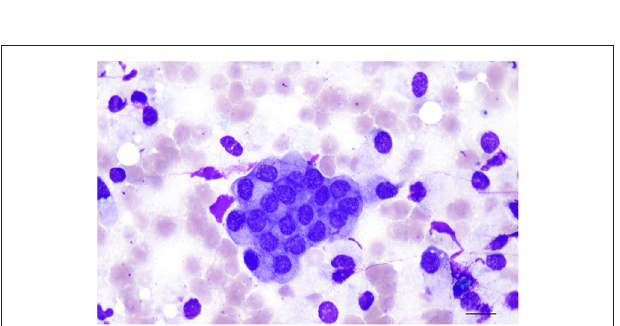
FIGURE 1 | Normal prostate gland from a sexually immature dog. Tissue section. (A) Prostate at 12 weeks of age with radiating branching ducts from the prostatic urethra (not visible; on the right-hand side). Hematoxylin-eosin staining. Bar = 400 µ m. (B) Prostate at 24 weeks of age: irregular glands with a small lumen and moderate amount of stroma. Hematoxylin-eosin staining. Bar = 200 µ m.